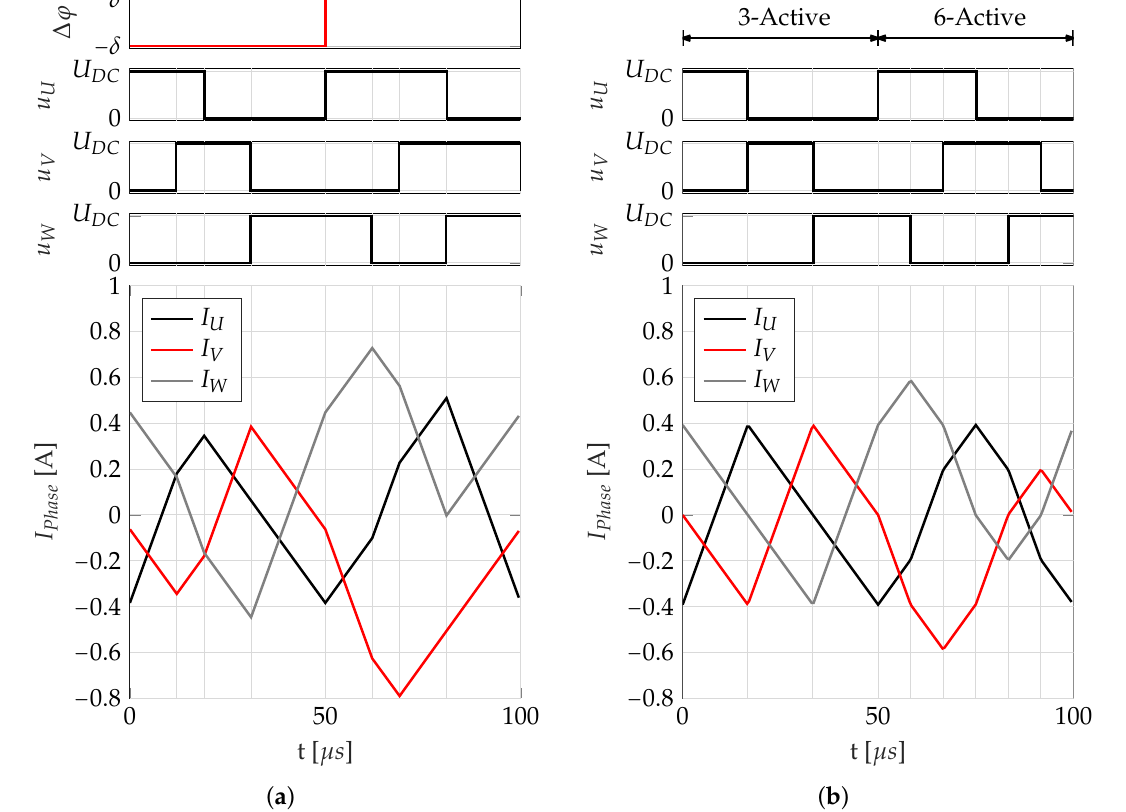
Figure 13. ( a ) Transient simulation of a sector switchover within the 4-Active SVM. The voltage space vector has an amplitude of zero but changes in the angle ϕ = π / 6 + ∆ ϕ to force a sector switchover. ( b ) Transient simulation of a switchover between the 3-Active and 6-Active SVM. Both SVMs represent a voltage space vector with zero amplitude ( f PWM = 20 kHz, t INF = 0.14, U DC = 48 V, δ = 0.001